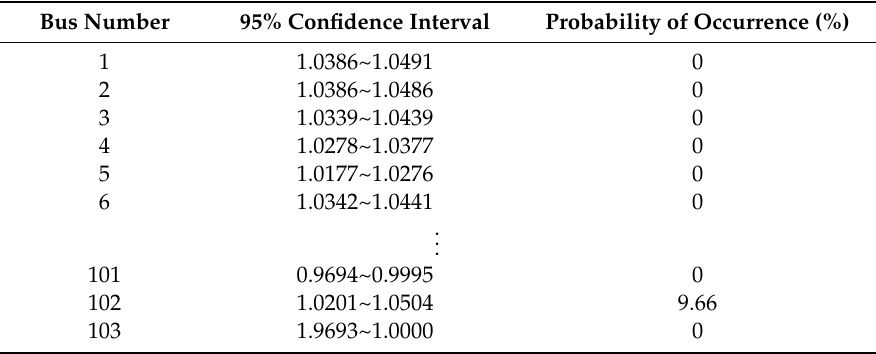
Table 8. Power flow data for post N-1 contingency; bus voltage